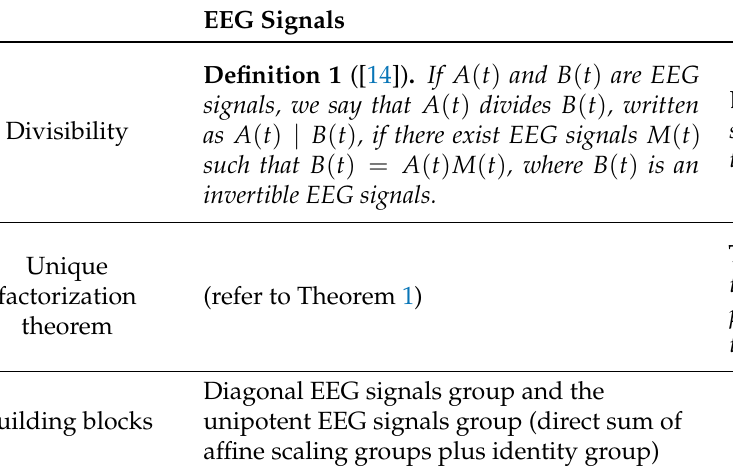
Table 1. Compatibility of EEG signals during a seizure to positive